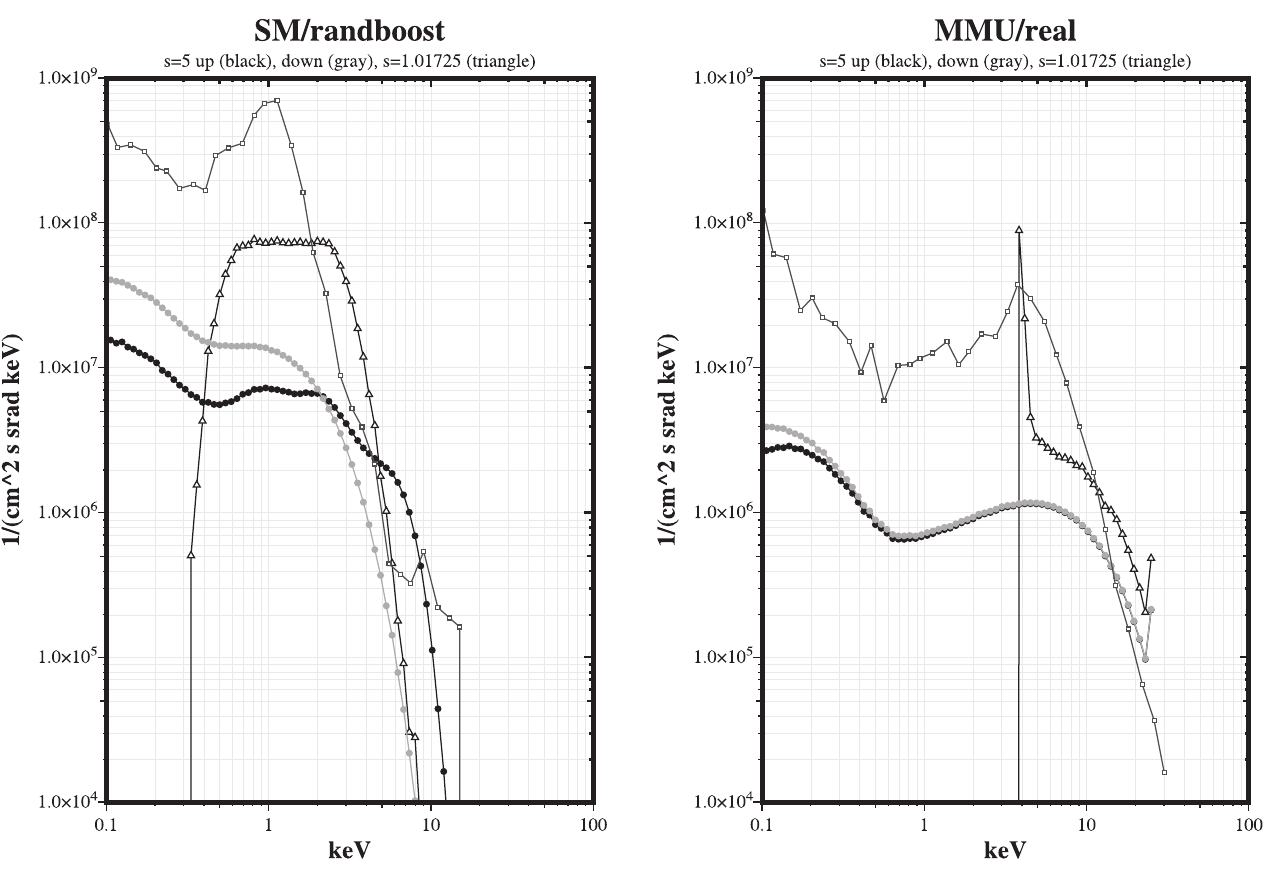
Fig. 12. SM/randboost: same as SMO/randboost but without electric field (only boosts left). The peak looks rather unrealistic now